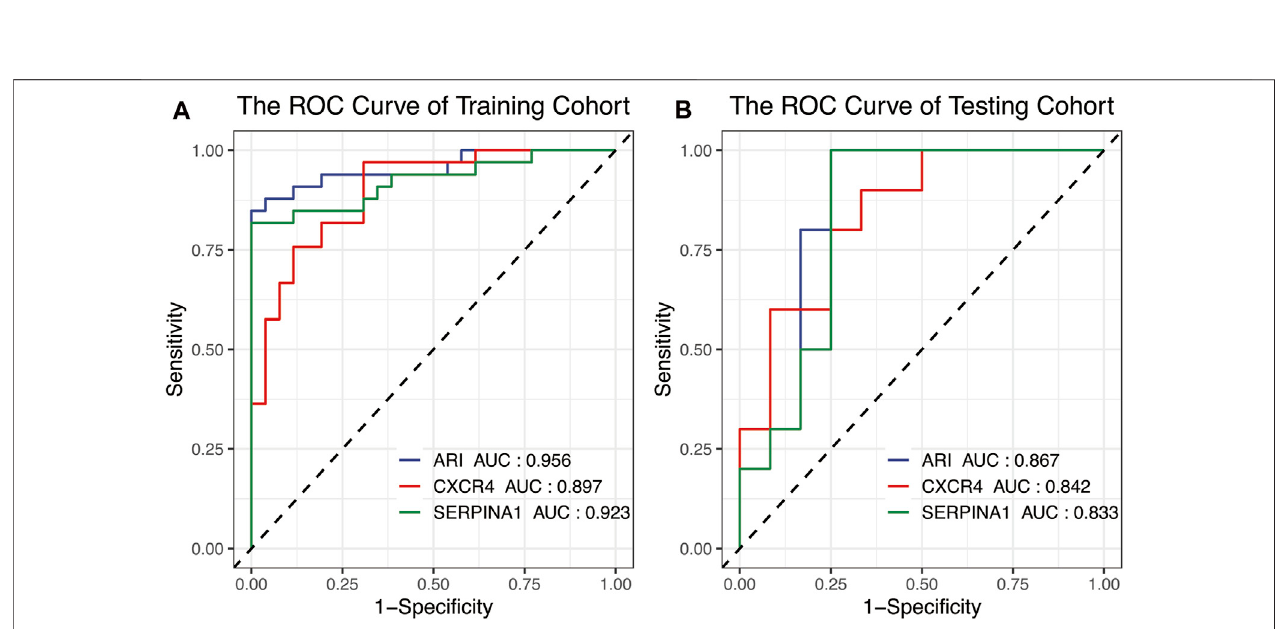
FIGURE 6 | The ROC curve used for the identi fi cation accuracy of autophagy-related genes CXCR4 and SERPINA1 and ARI for RA and OA. SERPINA1 , CXCR4 , and ARI all performed at high accuracy in the (A) training cohort and (B) testing cohort. ROC, receiver operating characteristic.